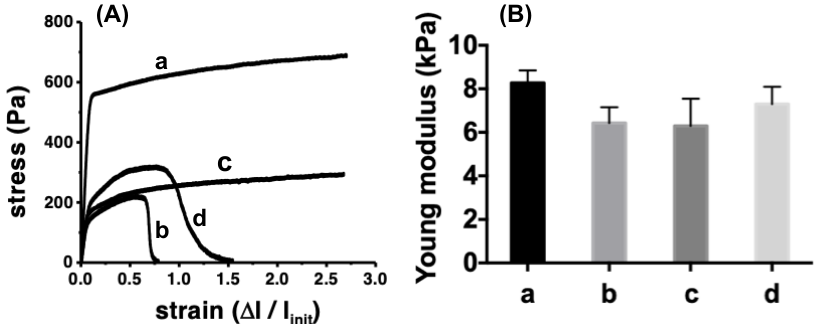
Figure 5. ( A ) Stress-strain plot and ( B ) calculated Young modulus for PCL fibers prepared using pristine PCL 394 ( a ), and those prepared in the presence of PEO 45 -b- PCL 11 ( b ), PEO 148 -b- PCL 13 ( c ), and PEO 230 -b- PCL 184 ( d ).